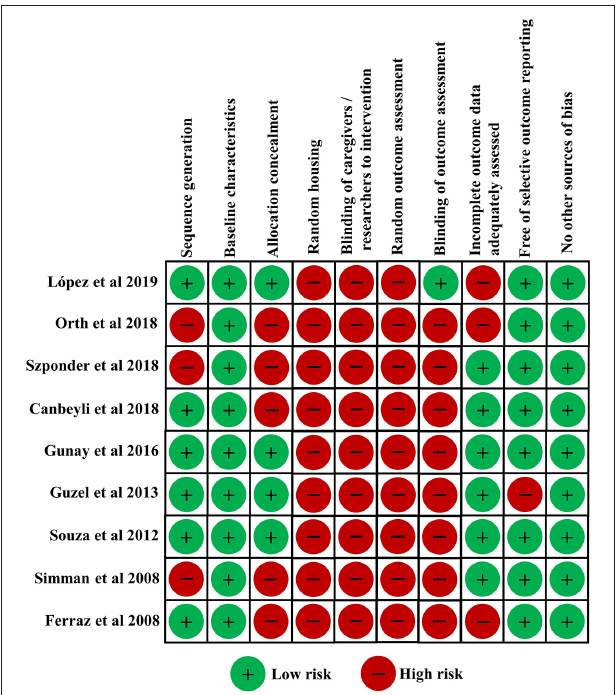
FIGURE 3 | The risks of bias of all enrolled animal